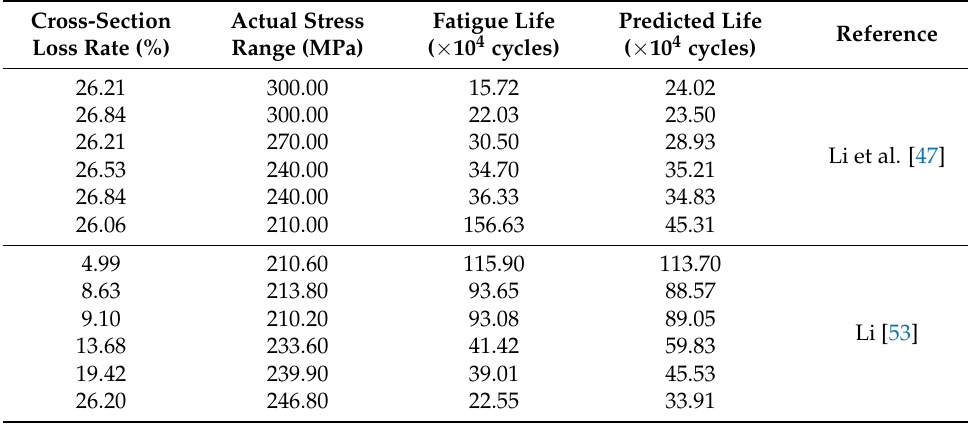
Table 2. Predicted results of corroded RC beams in the